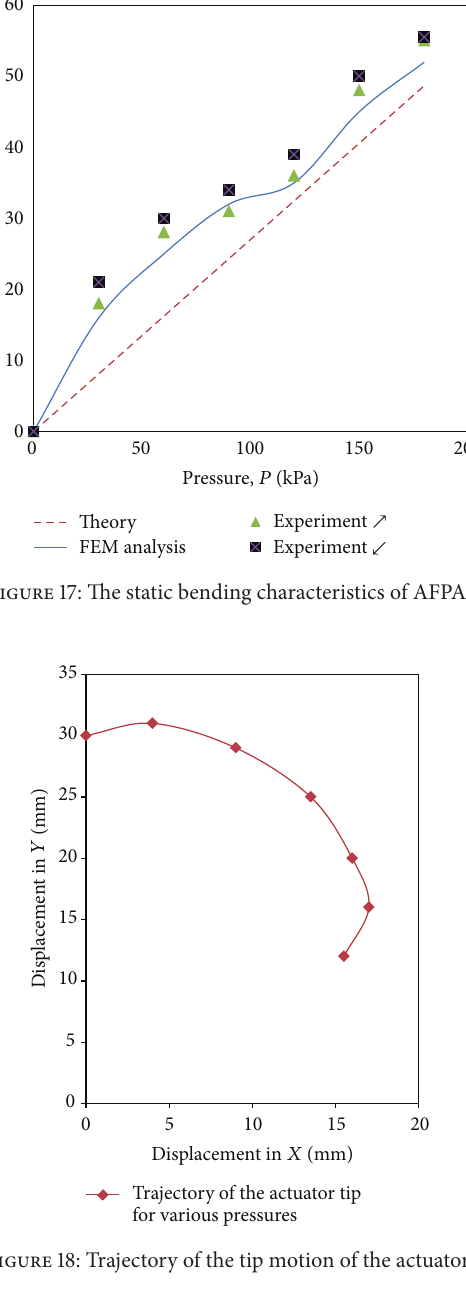
internal air pressures. The pressure range is from 0 to 180 kPa.